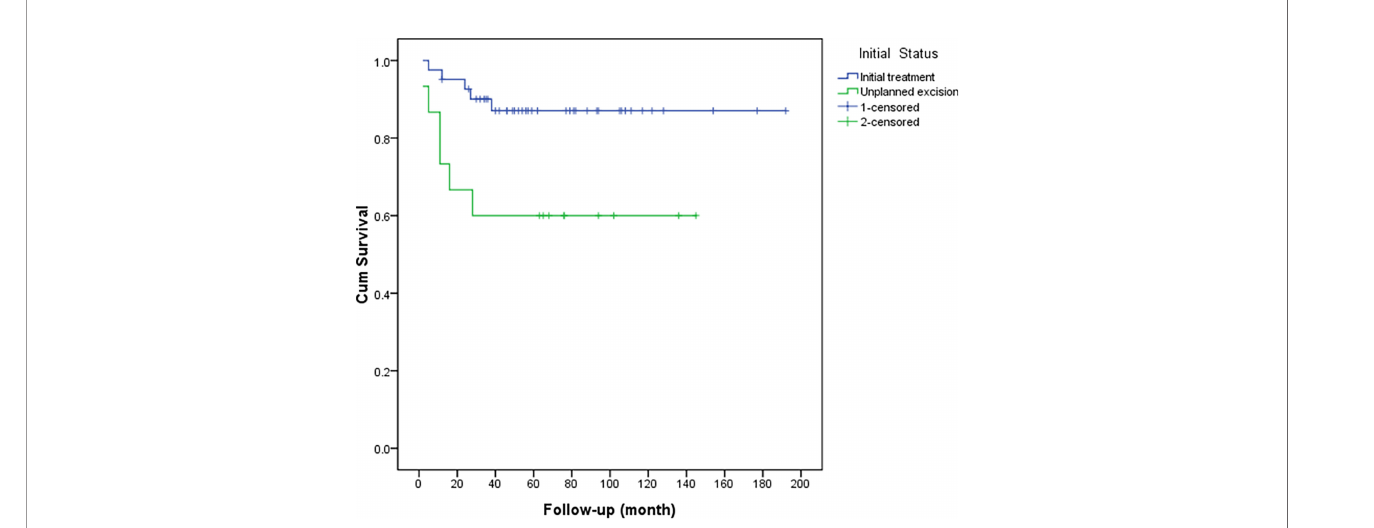
FIGURE 2 | Comparison of recurrence-free survival between patients with recurrence after unplanned excision and those with initial treatment (P =